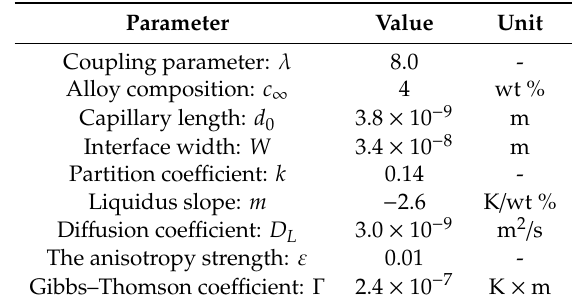
Figure 2. The initial condition of simulation: ( a ) the scalar field φ ; ( b ) the temperature distribution. Table 1. The values of parameters involved in phase-field modeling.